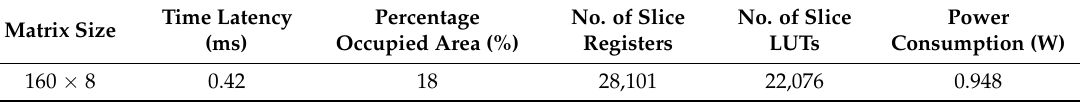
Table 2. SVD implementation results for Virtex-5 XC5VLX330T.